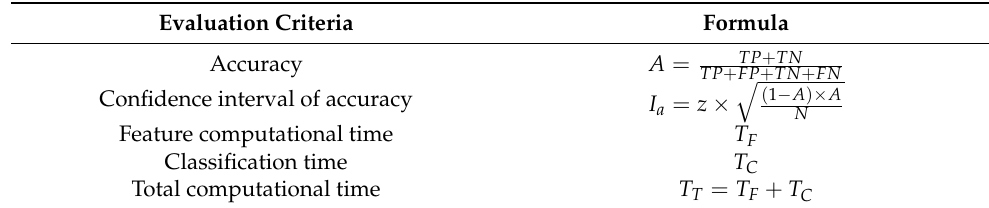
Table 2. Overview of evaluation criteria for LCIC. z = 1.96 for 95% confidence interval and the number of samples N is 800